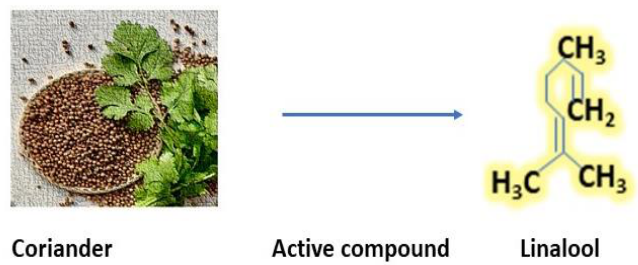
Figure 4. Active compound of coriander (Linalool) [71].